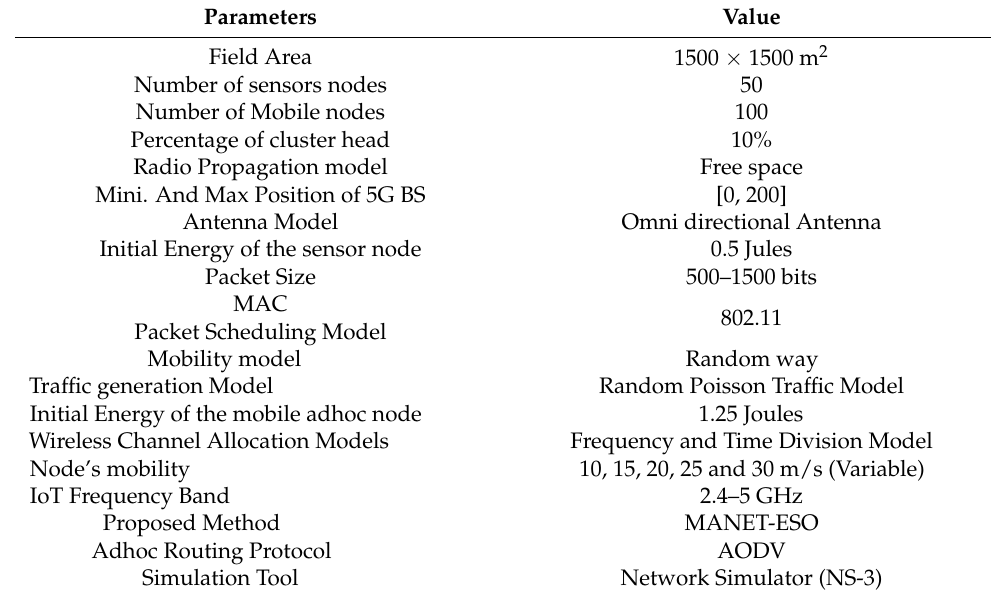
Table 2. Simulation